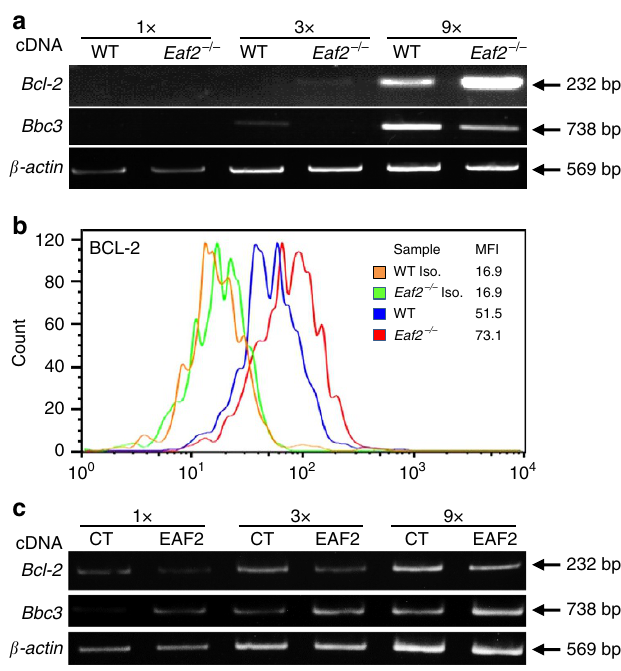
Figure 7 | EAF2 regulates Bcl-2 and Bbc3 / Puma expression in GC B cells. ( a ) Semi-quantitative RT-PCR analysis of Bcl-2 and Bbc3 expression in sorted WT and Eaf2 (cid:3) / (cid:3) GC B cells. Increasing amounts of the template cDNA were used. b -actin was used as an internal control. ( b ) Intracellular staining of BCL-2 in GC B cells of WT and Eaf2 (cid:3) / (cid:3) mice. Mean fluorescence intensity (MFI) is shown in the upper right. Blue, WT; Red, Eaf2 (cid:3) / (cid:3) ; Orange and green, isotype control of WT and Eaf2 (cid:3) / (cid:3) . Similar results were obtained in three independent experiments. ( c ) Ectopic EAF2 expression downmodulated Bcl-2 and upregulated Bbc3 transcription in spleen B cells. Purified spleen B cells were cultured for 24h in the presence of 10 m gml (cid:3) 1 of LPS and then transduced with retrovirus expressing EAF2- IRES-GFP (EAF2) or GFP alone (CT). Cells were harvested 24h after retroviral transduction and subjected to RT-PCR analysis. Representative